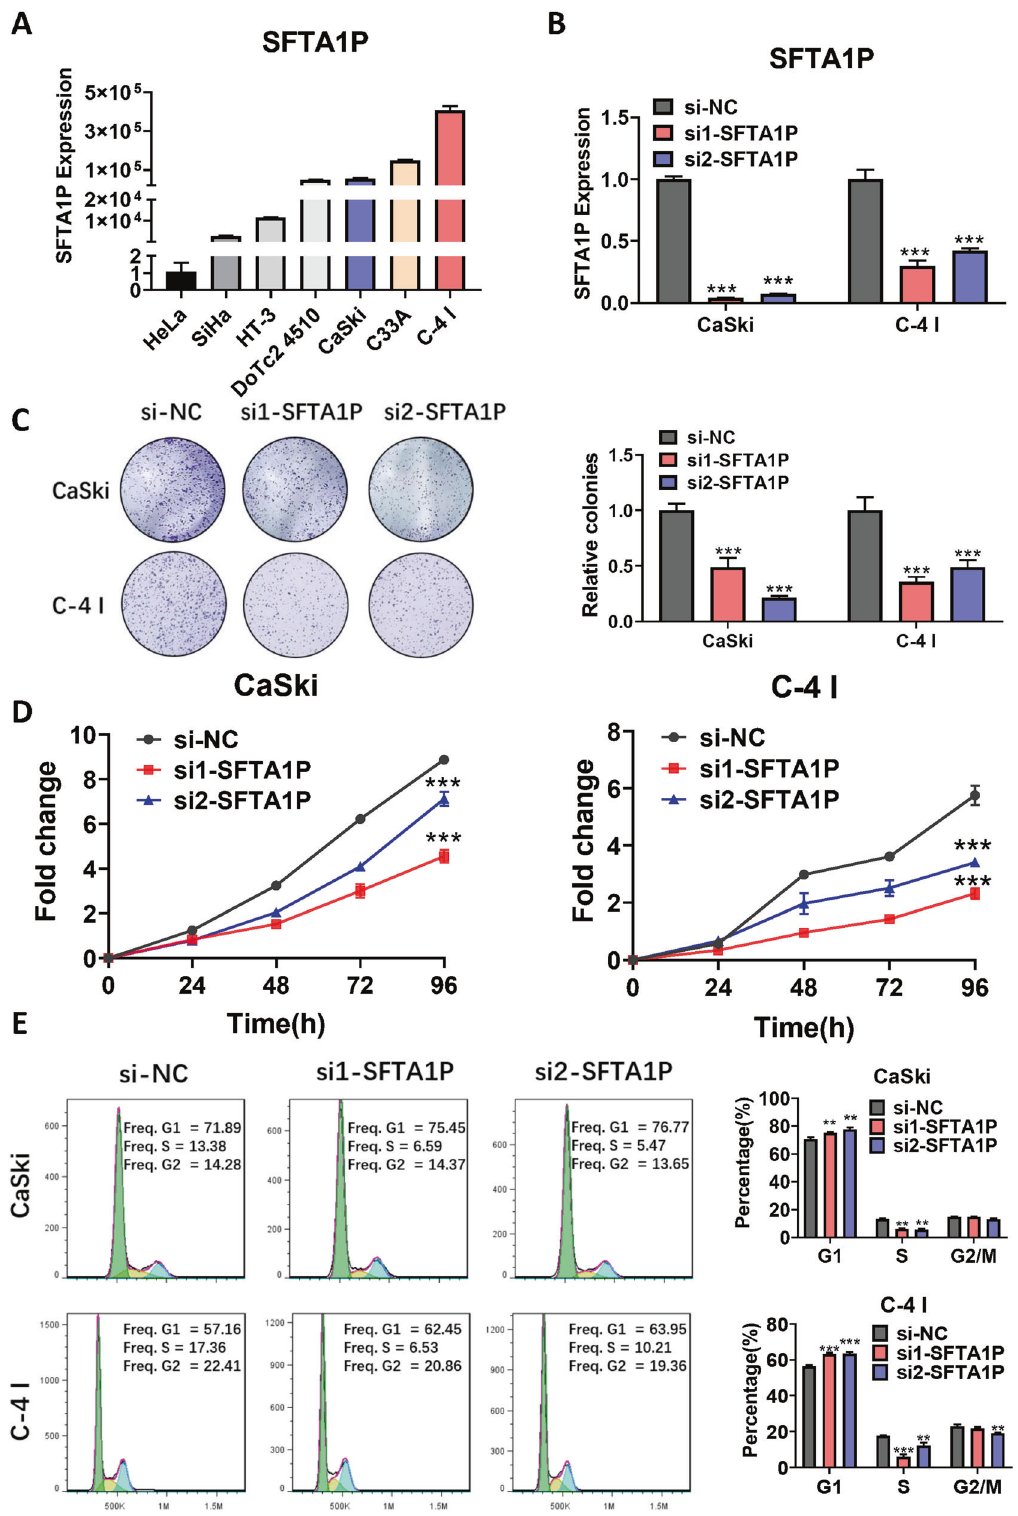
Fig. 2 SFTA1P promotes cervical cancer cell proliferation in vitro and in vivo. A Relative expression levels of SFTA1P in different cervical cancer cell lines. B Relative expression levels of SFTA1P in cervical cancer cells transfected with siRNA, as determined by qRT-PCR. C Clonogenic assays of cells transfected with SFTA1P siRNA and negative control (NC). D Proliferation of cells transfected with SFTA1P siRNA and NC, as assessed by CCK8 assays. E Flow cytometry analysis of cell cycles of cells transfected with SFTA1P siRNA or NC. Data are shown as mean ± SEM. * P < 0.05; ** P < 0.01; *** P < 0.001.